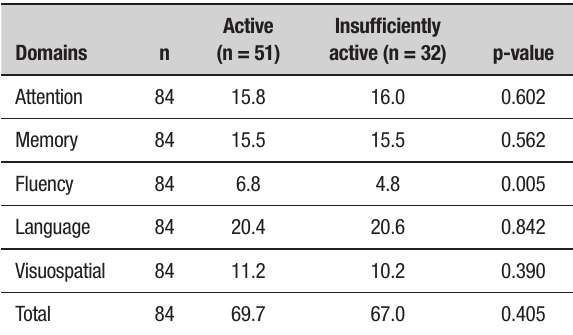
Table 3. Comparison of active and insufficiently active HD patients and cog- nitive